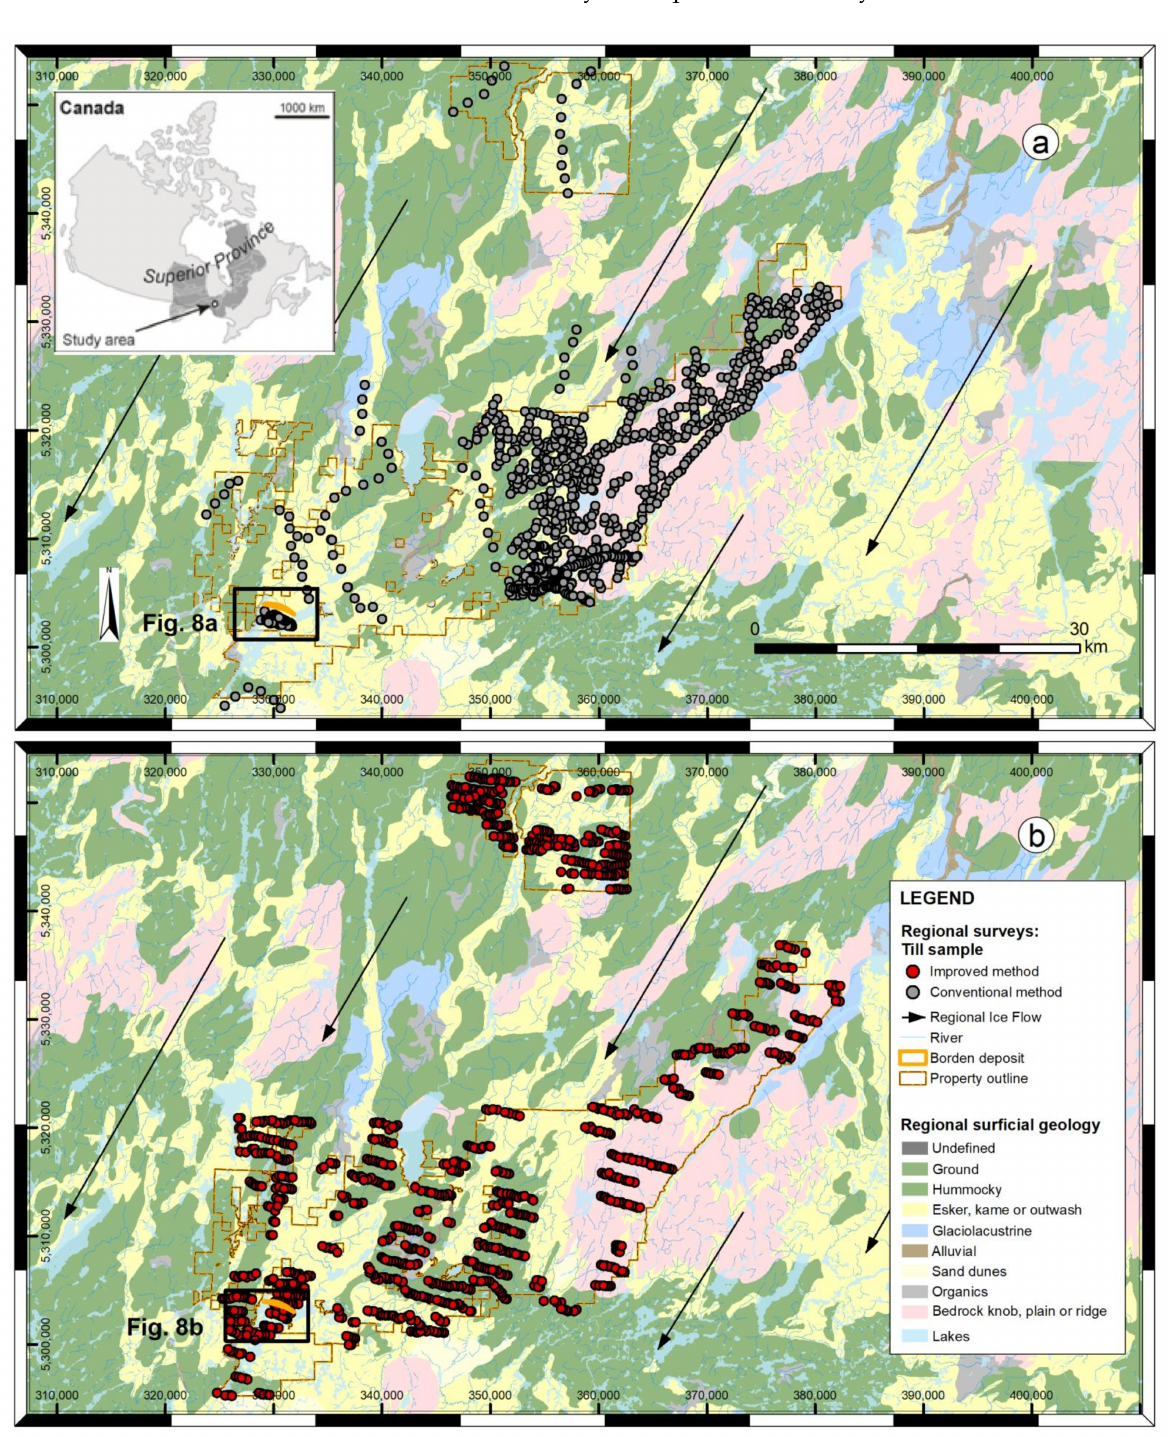
Figure 7. Map of the regional area surrounding the Borden gold deposit, showing a surficial geology and the locations of the till samples processed with the conventional method ( a ) and the improved method ( b ). The number of samples for the conventional method n = 833 and for the improved method n = 1192 should be